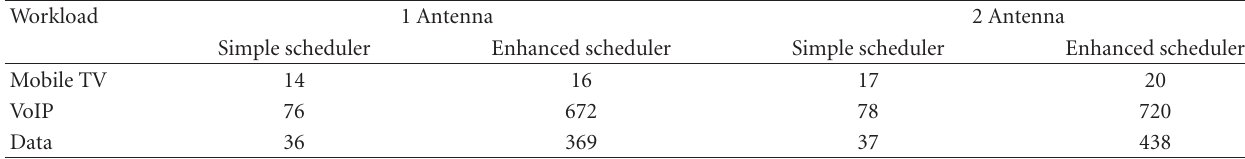
Table 14: Number of supported users in a lossy